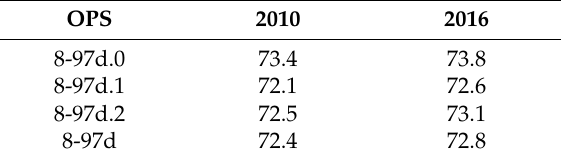
Table 3. Mean age of the PD-MCT-patients according to subcategories for the years 2010 and